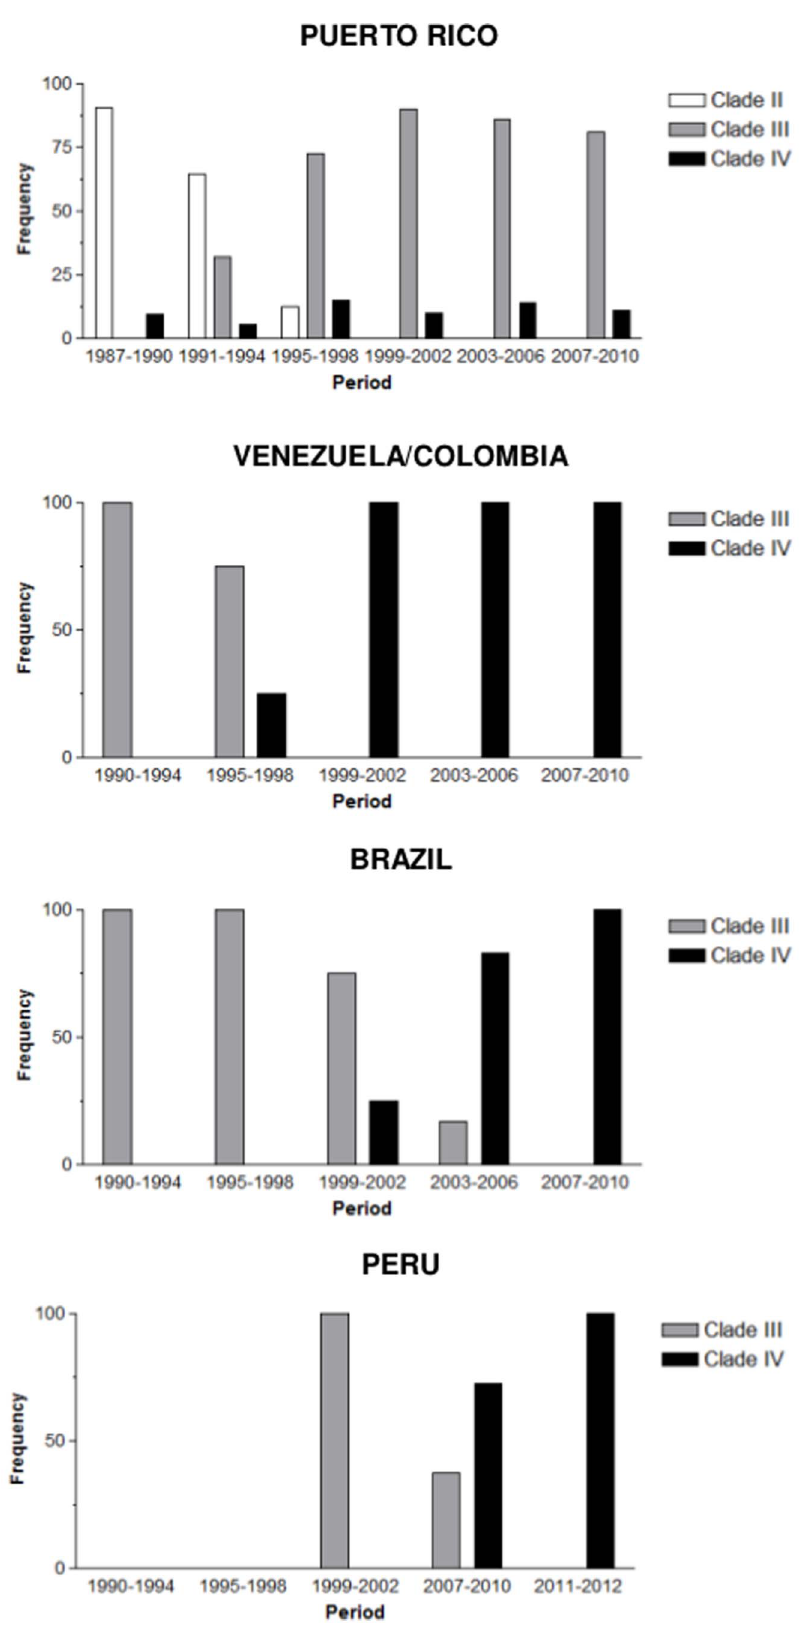
Figure 7. Distribution of DENV-2 AS/AM genotype sequences isolated in Puerto Rico ( n =195), Brazil ( n =77), Venezuela/Colombia ( n =64), and Peru ( n =38) at different time periods across the major phylogenetic lineages. doi:10.1371/journal.pone.0098519.g007 PLOS ONE |